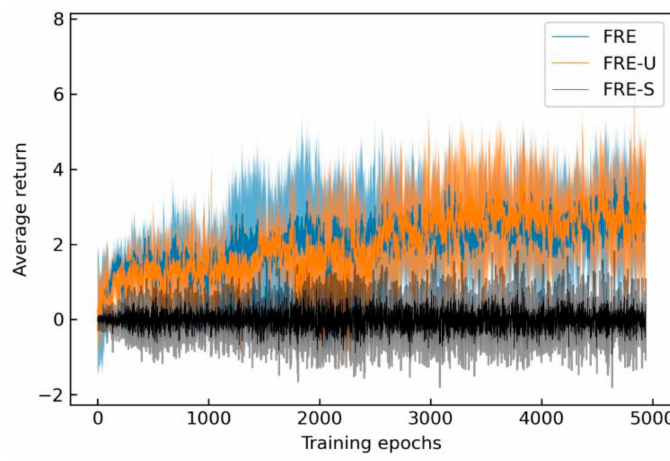
Figure 3. Average